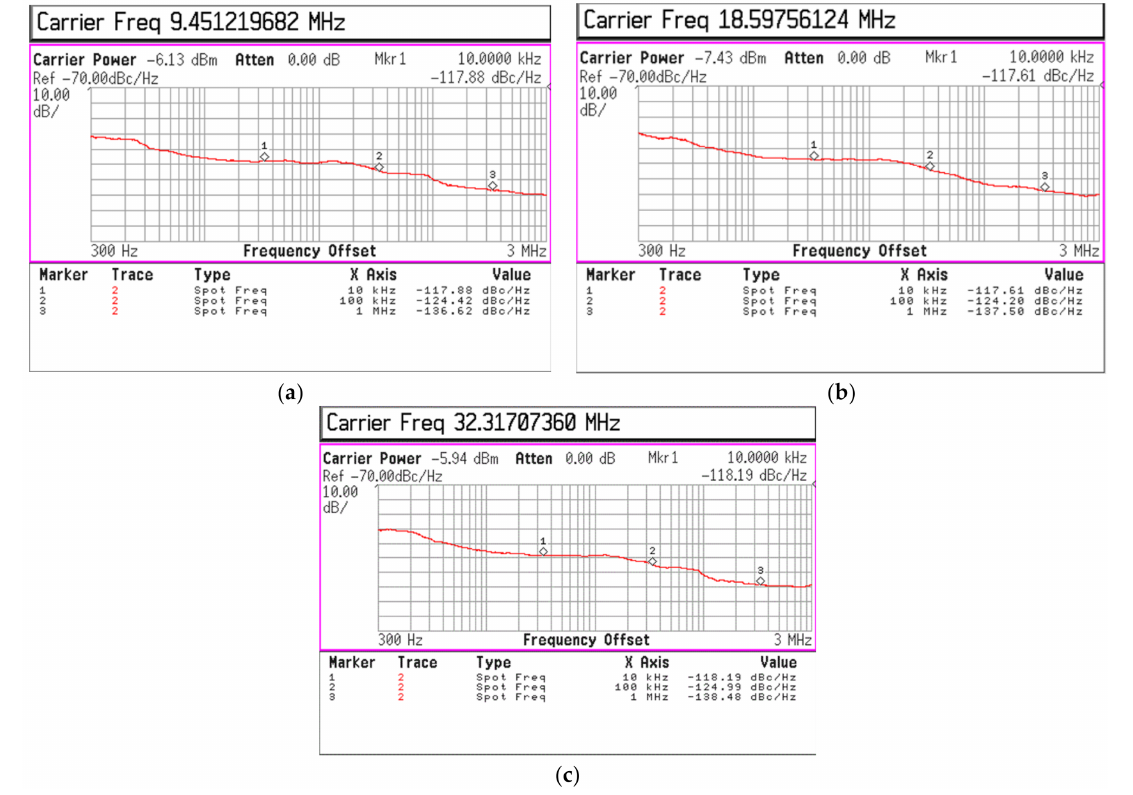
Figure 11. Measured phase noise of the improved programmable integer divider’s output signal: ( a ) f in = 6.2 GHz, n = 656, and f out = 9.452 MHz; ( b ) f in = 11.3 GHz, n = 608, and f out = 18.597 MHz; and ( c ) f in = 19 GHz, n = 588, and f out = 32.32 MHz.